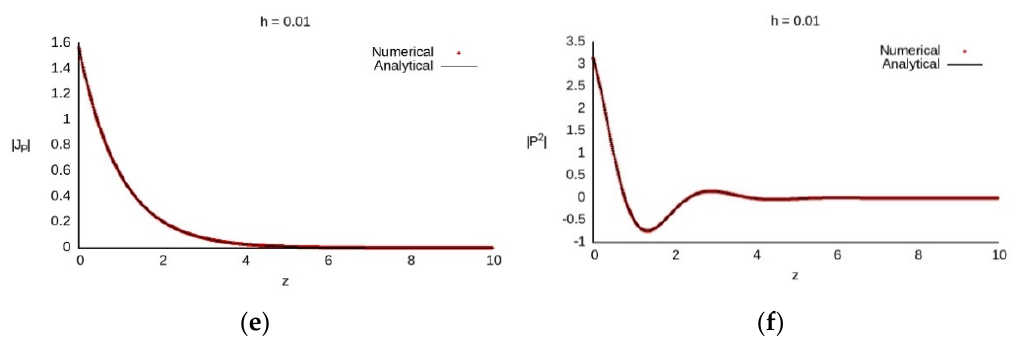
( f ) J z (4a) and 2 ( , ) P z L (4b), computed Mathematics 2022 , 10 , x FOR PEER REVIEW 21 of 27 Figure 6. Evolution of the modulus of the invariants J p ( z ) (4a) and P 2 ( z , L t ) (4b), computed with Figure 6. Evolution of the modulus of the invariants ( ) p t parameters D 2 ω = − 0.01, δ 0 = 1, n 0 = 1 via computer simulation (red dotted line) and analytically δ= − = = D n 0.01, 1, 1 with parameters via computer simulation (red dotted line) and ana- ω (black solid line) for different values of the following spatial steps: h = 0.1 ( a , b ), 0.05 ( c , d ), 0.01 ( e , f ). 2 0 0 = ( a , b ), 0.05 lytically (black solid line) for different values of the following spatial steps: 0.1 h ( c , d ), 0.01 ( e , f ).